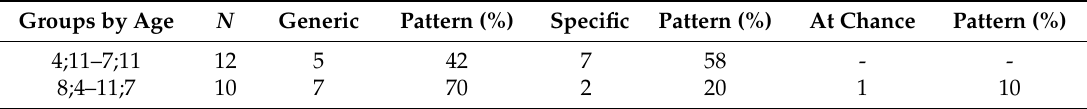
Table 3. Bare NPs: Individual subject patterns.